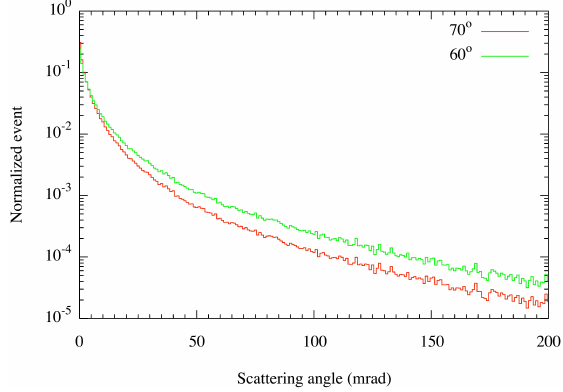
Figure 12. Scattering angle distribution of near-horizontal muons. The events are normalized by the total number of muons that were injected.